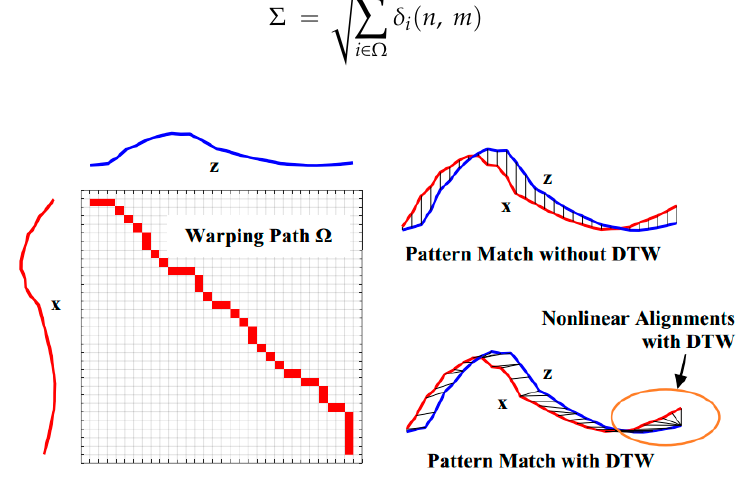
Figure 1. Dynamic time warping.